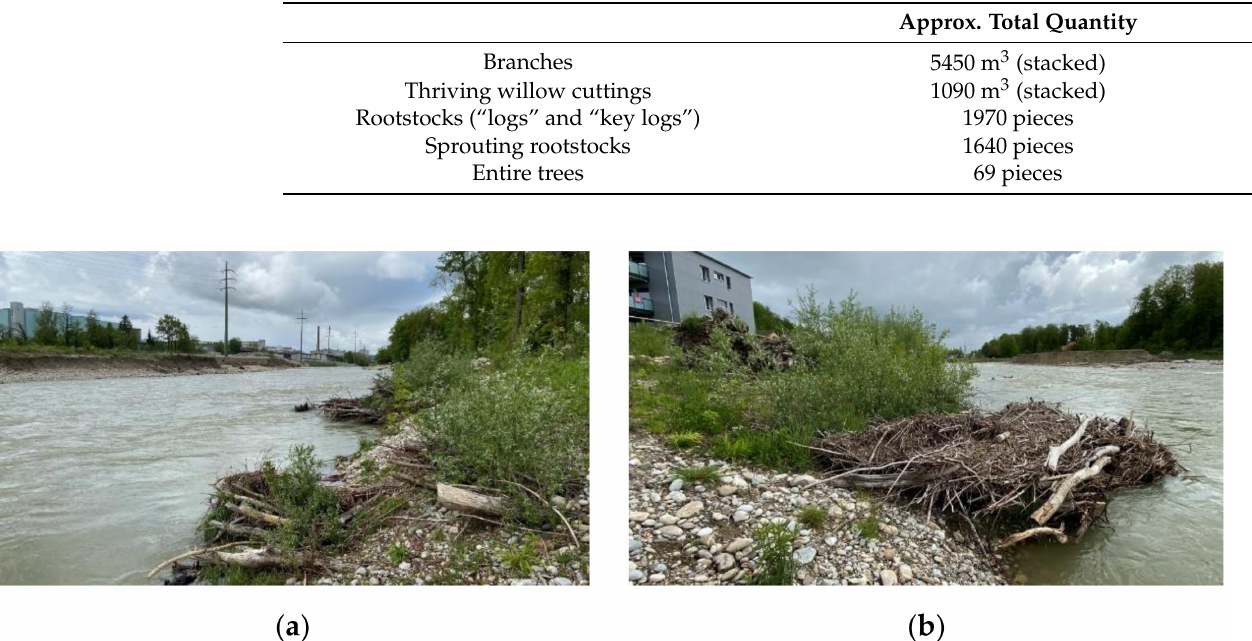
Figure 8. ( a , b ) Structured riverbanks with LWS combined with thriving willow cuttings acting as a driftwood trap and offering cover for fish; Emme River; Photo: M.